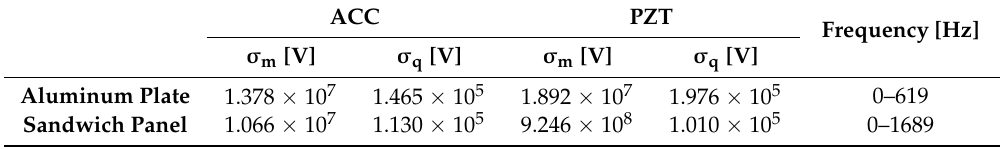
Table A4. Linear regression coefficient uncertainties; automatic